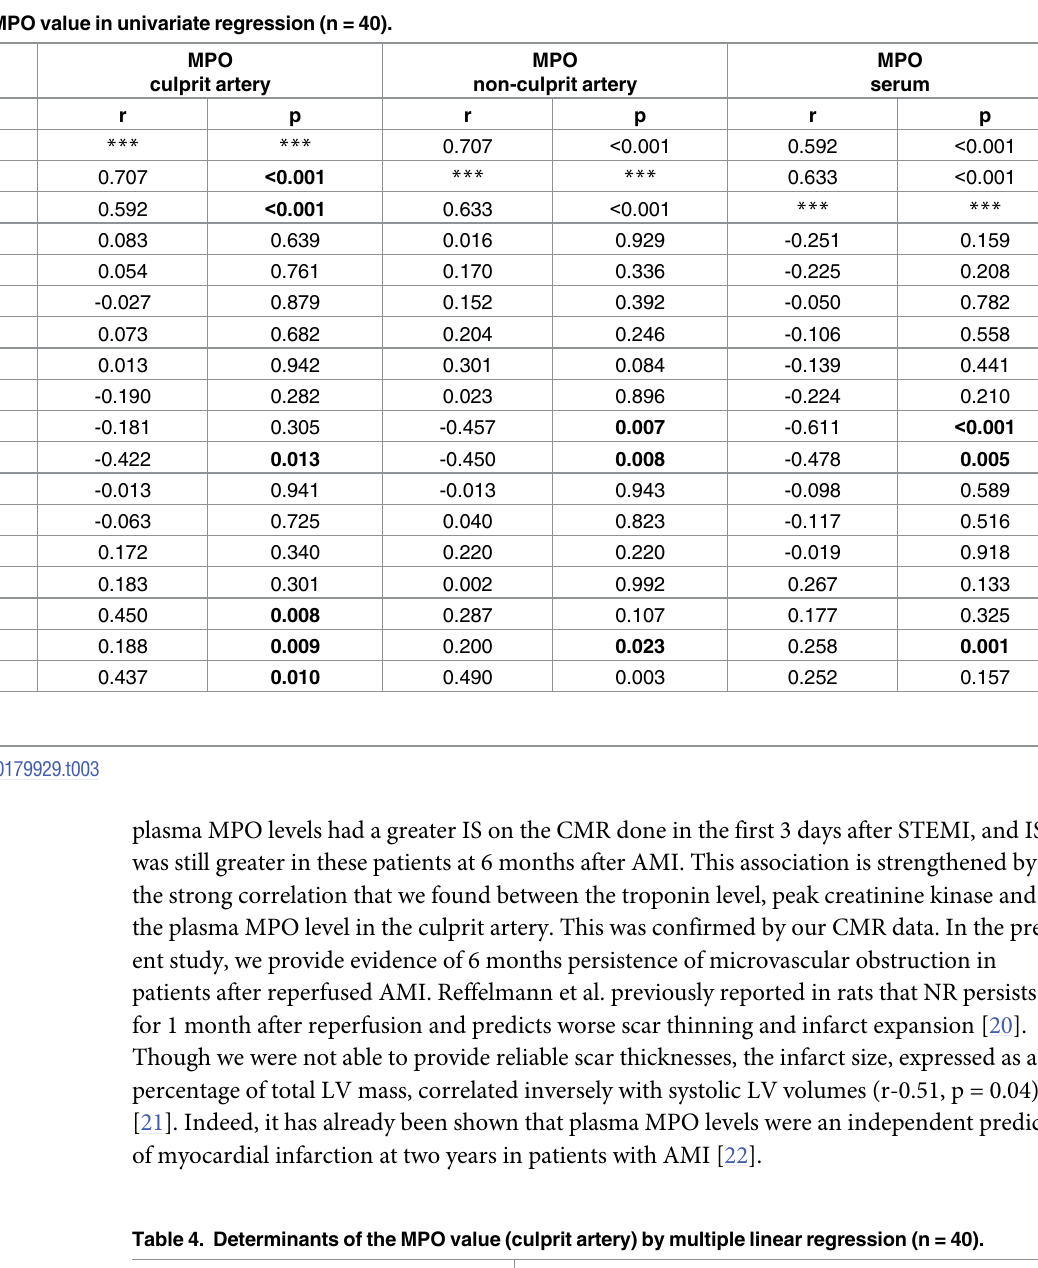
Table 4. Determinants of the MPO value (culprit artery)by multiple linear regression (n = 40). Total Population